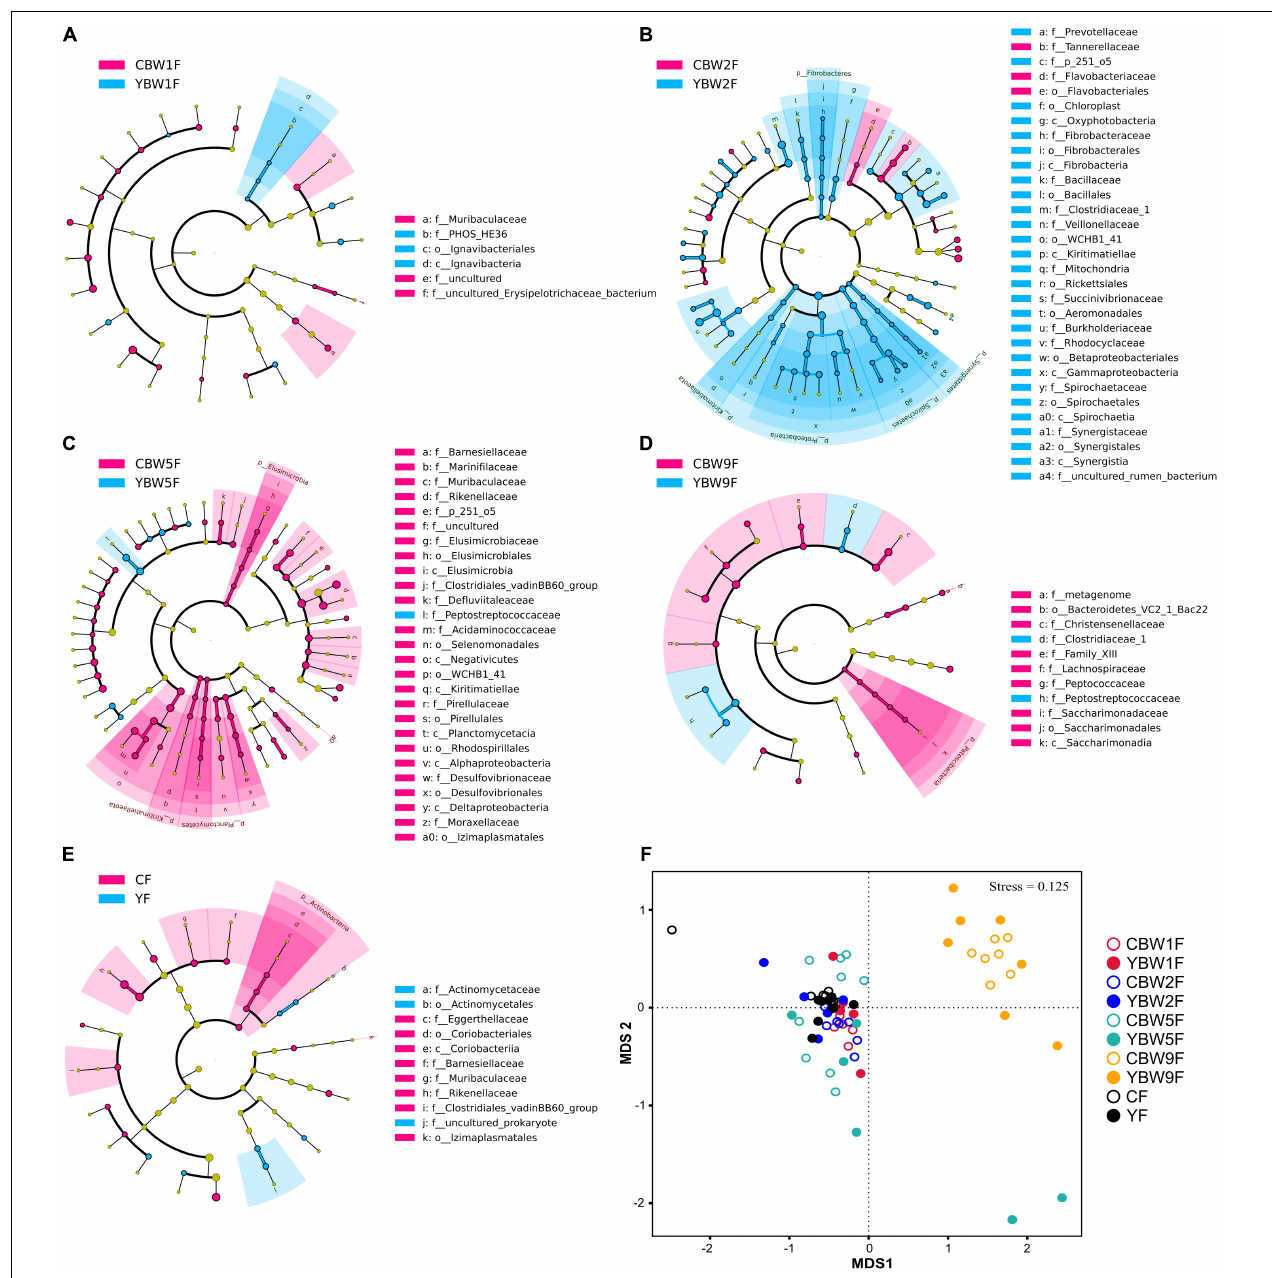
FIGURE 5 | Linear discriminant analysis effect size analysis of the intestinal microbial community structure of yak and cattle calves at different weeks after birth. The cladograms indicate the phylogenetic distribution of the intestinal microbiota of yak and cattle calves at 1 week of age (A) , 2 weeks of age (B) , 5 weeks of age (C) , 9 weeks of age (D) , and their mothers at 1 weeks postpartum (E) using the linear discriminant analysis (LDA) effect size (LEfSe) method. Differences are represented by treatment colors (blue indicates yak, pink indicates cattle, and yellow non-significant). Circles represent taxonomic ranks from domain to species from inside to out layers. The LDA cut-off score is 2. Letters in front of ASVs represent taxonomic levels (p, phylum; c, class; o, order; and f, family). (F) The gut microbial community structures across calf and maternal samples. Non-metric multidimensional scaling (NMDS) ordination based on Bray–Curtis distances among sample types are plotted based on ASV abundances in the calf and maternal fecal samples. YF and CF represent fecal samples from yak and cattle during the first week of postpartum, respectively.